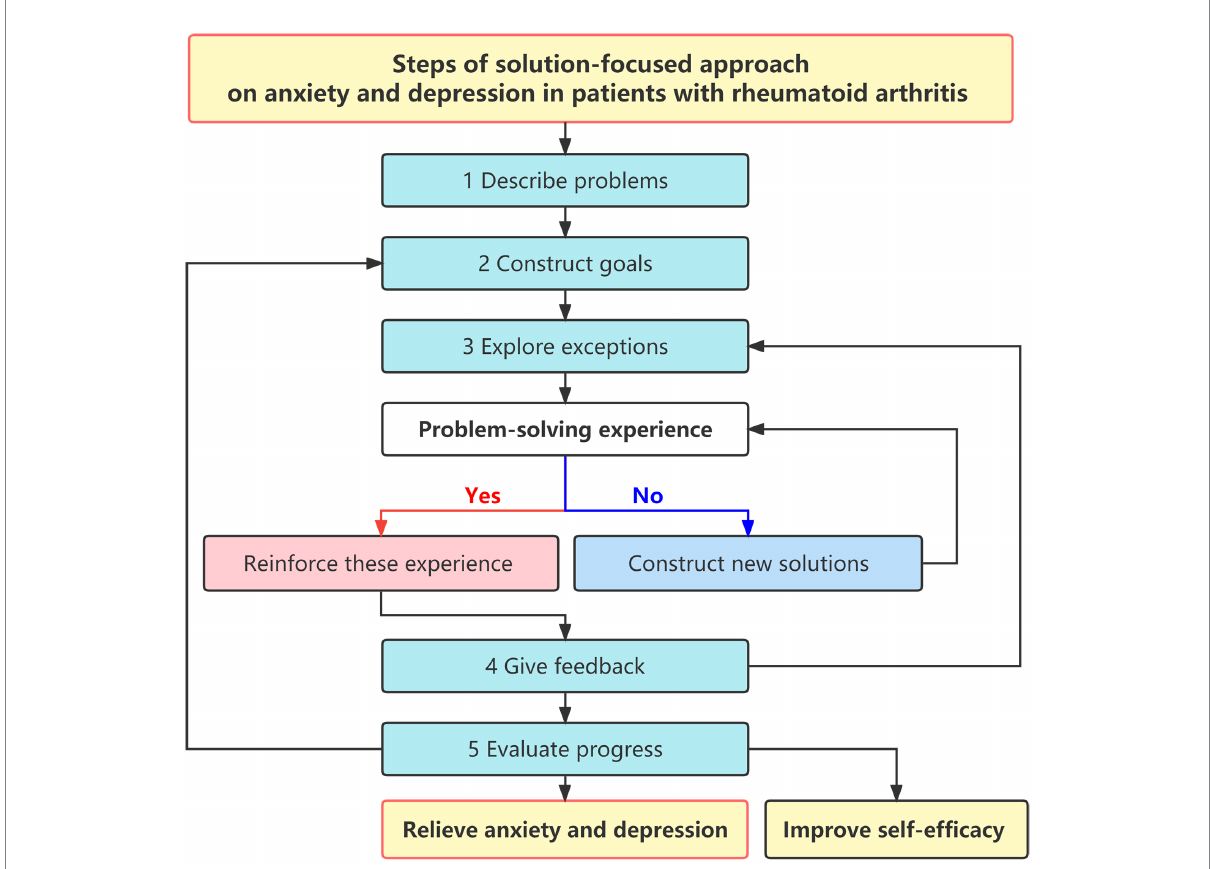
FIGURE 1 Steps of solution-focused approach on anxiety and depression in patients with rheumatoid